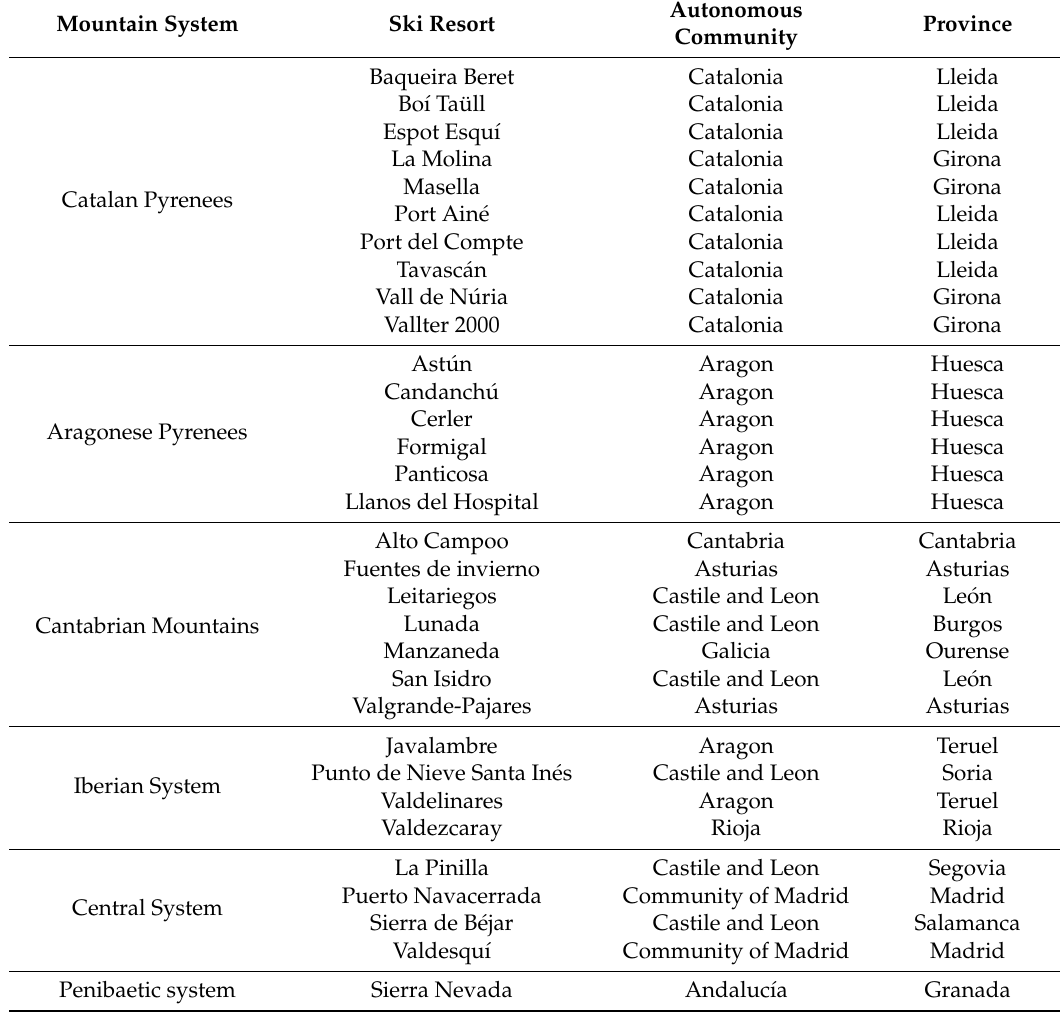
Table A1. List of mountain systems, ski resorts, Autonomous Communities, and